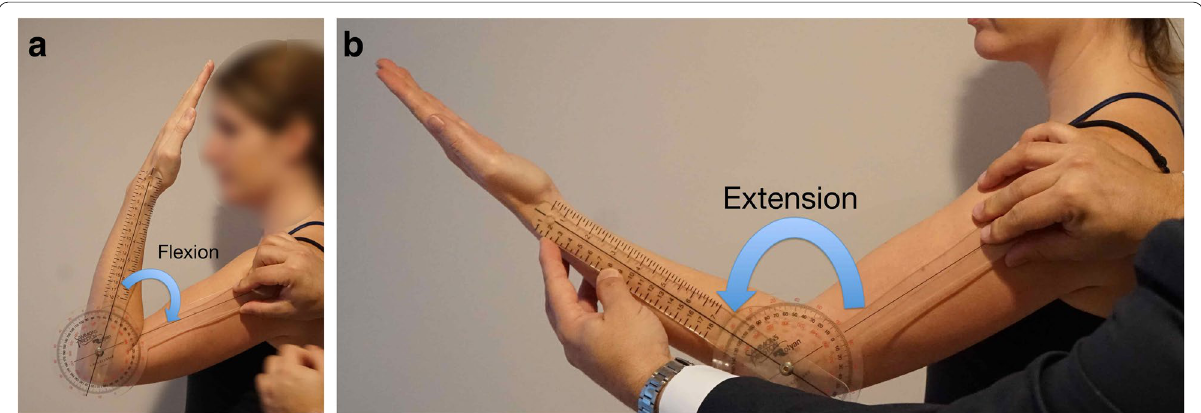
Fig. 1 Clinical assessment of elbow flexion ( A ) and extension ( B ) is best performed with the forearm in supination and the flexion‑extension axis parallel to the floor using a